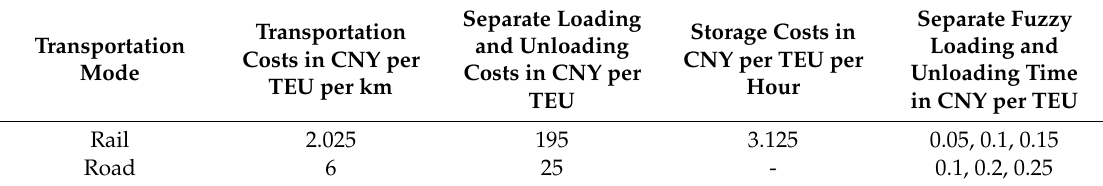
Table A3. The values of the cost and operation parameters defined in Table 3.